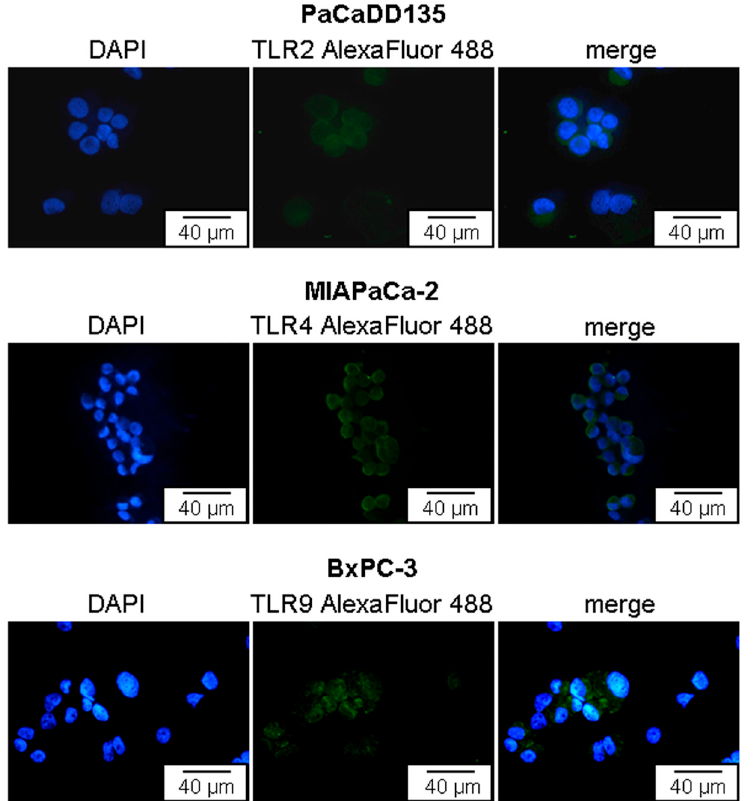
Figure 4. Immunofluorescent staining of TLR2, -4, and -9 in PaCaDD135, MIAPaCa-2, and BxPC-3 pancreatic cancer cells. Representative examples showing TLR2, -4, and -9 expression (green). Cell surface localization of TLR2 and -4 as well as intracellular localization of TLR9 can be identified. AlexaFluor 488, green; DAPI (49,6-diamidino-2-phenylindoldihydrochlorid), blue—nuclear counterstaining.